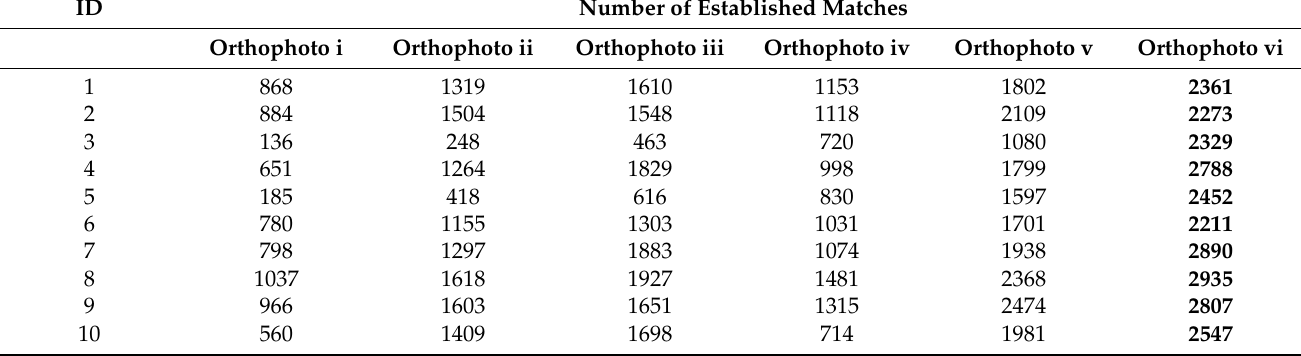
Figure 17. SIFT-based matchings between the original frame image (left) and generated orthophoto for a given row seg- ment using different DSM smoothing and seamline control strategies (right) for: ( a ) orthophoto i, ( b ) orthophoto ii, ( c ) orthophoto iii, ( d ) orthophoto iv, ( e ) orthophoto v, and ( f ) orthophoto vi.